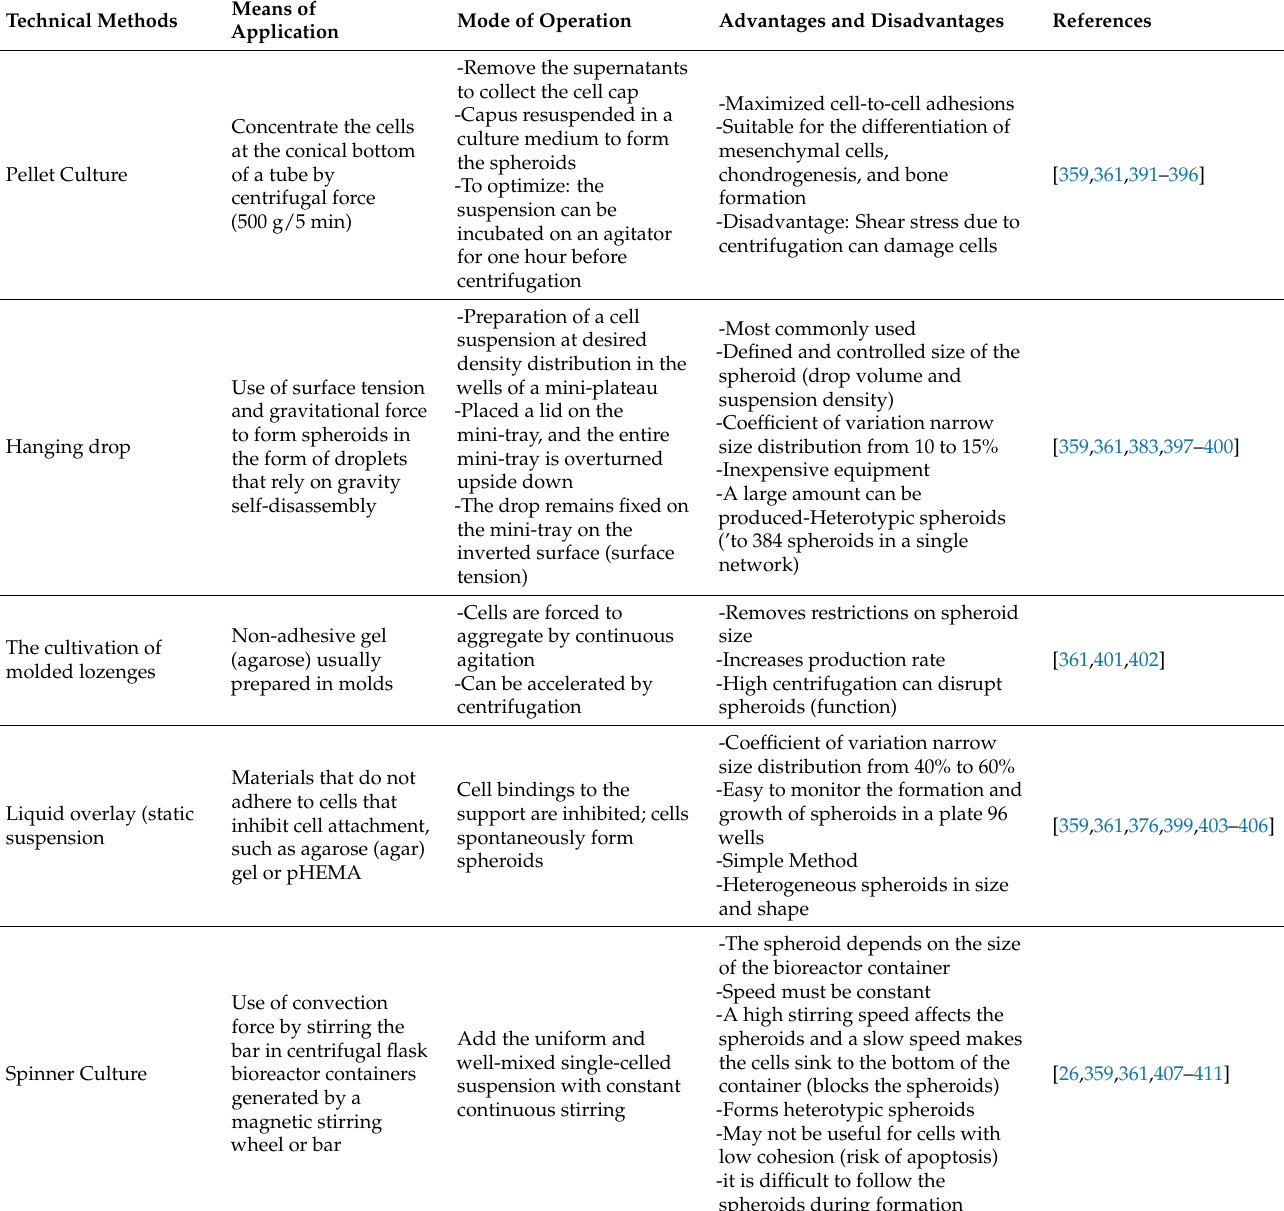
Table 7. Technical methods of spheroid